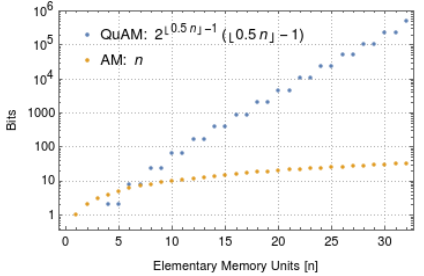
Figure 2. Capacity of quantum versus classical associative memories as a function of the number of elementary physical storage units (conventional memory cells in the classical case, and 2-level qubits in the quantum one).